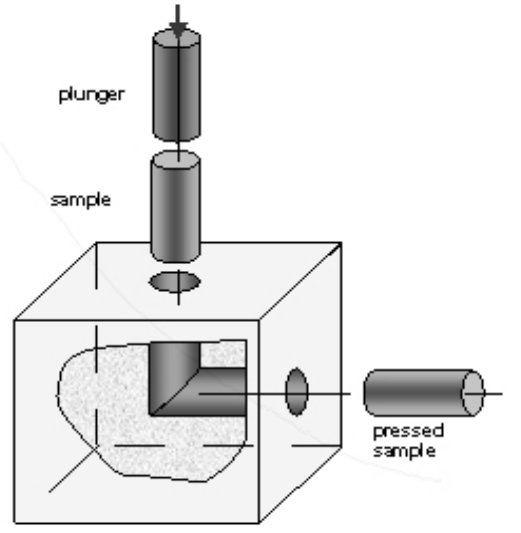
Fig. 16: Dependence of the minimum deflection rate on the applied force